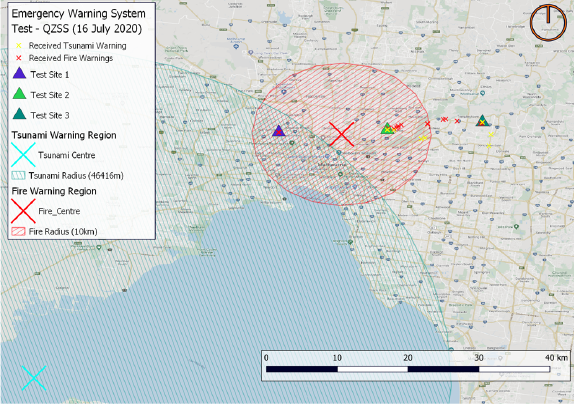
Figure 4. Map of the Melbourne EWS test on 16 July